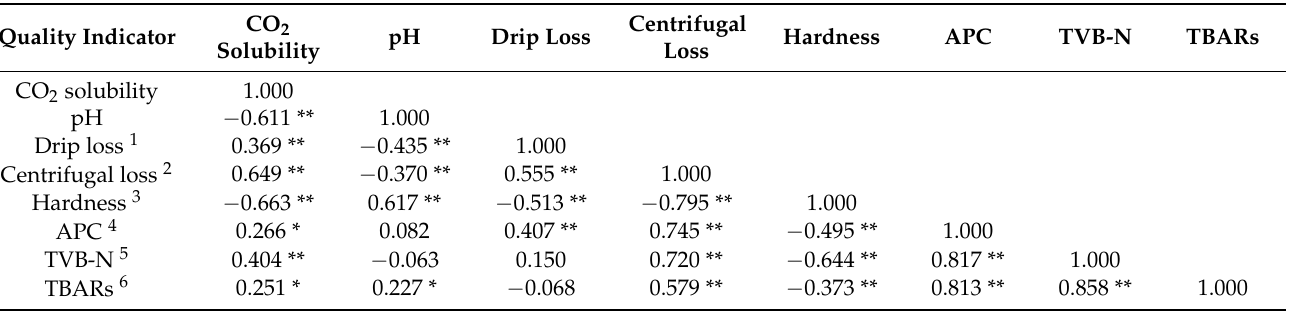
Table 1. Pearson correlation analysis of quality indicators in golden pompano fillets during